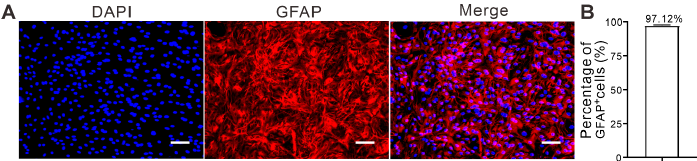
Figure 1. Purity of rat primary non-prefrontal cerebral cortical astrocytes. ( A ) Representative images of GFAP immunostaining in astrocytes. Red fluorescence indicates GFAP-positive astrocytes. Blue fluorescence indicates nuclei. ( B ) The ratio of GFAP-positive cells to nuclei represents the purity of astrocytes. The experiment was repeated three times, and more than 95% of cells were GFAP-posi- tive. Scale bar: 75 µm. GFAP: Glial fibrillary acid protein.